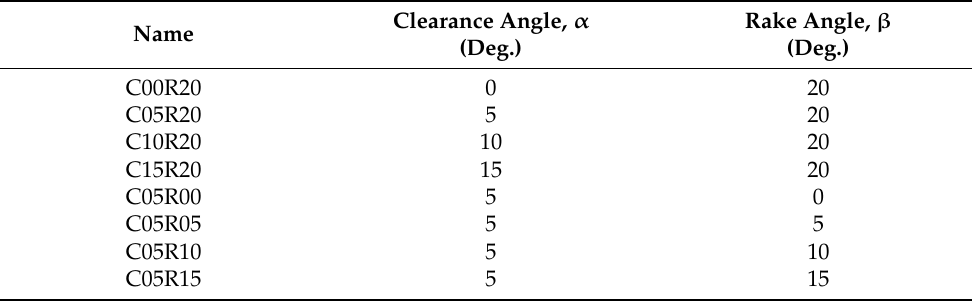
Table 2. Physical and mechanical properties of the model rocks.